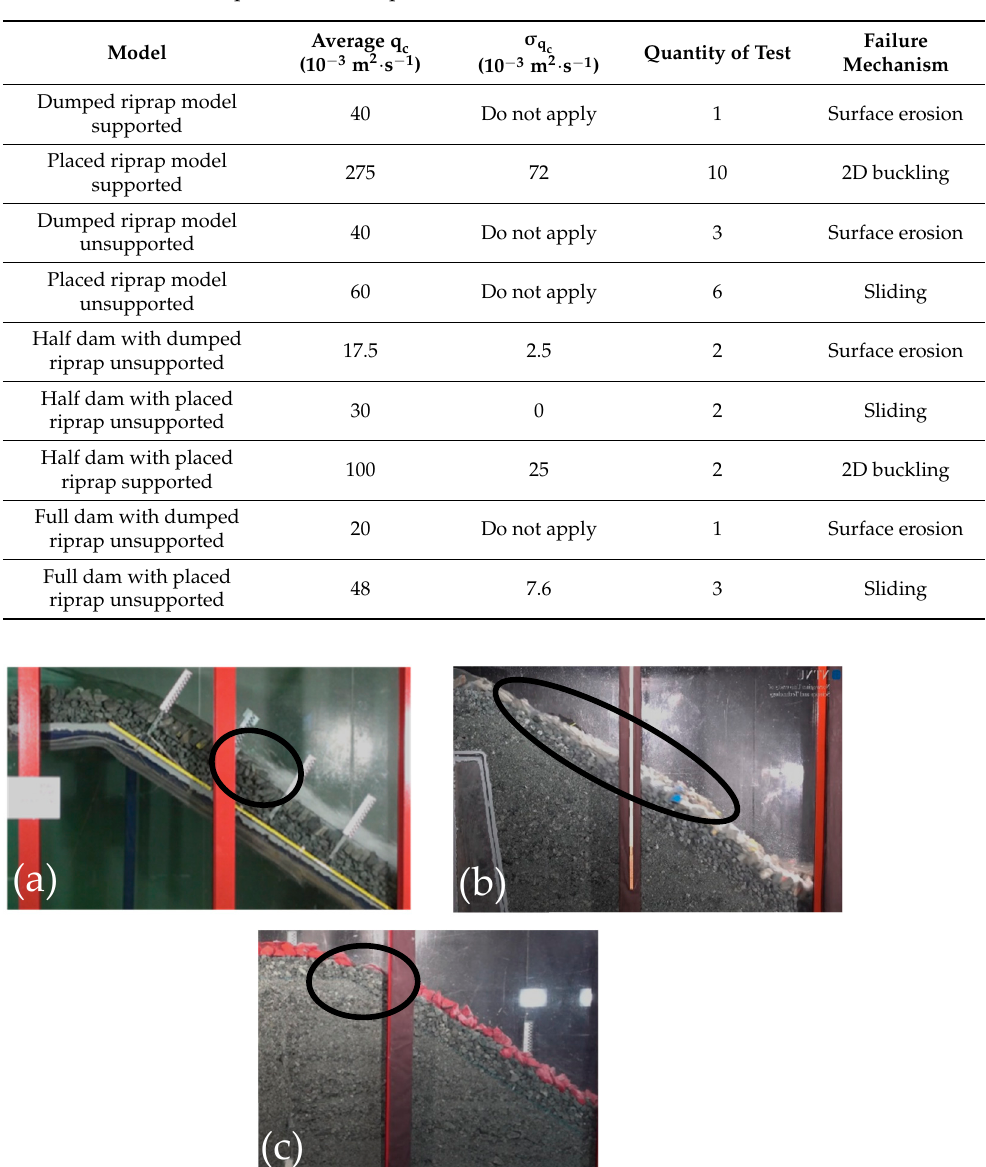
Table 2. Average and standard deviations of critical discharge, quantity of test, and failure mechanism associated with each experimental setup.